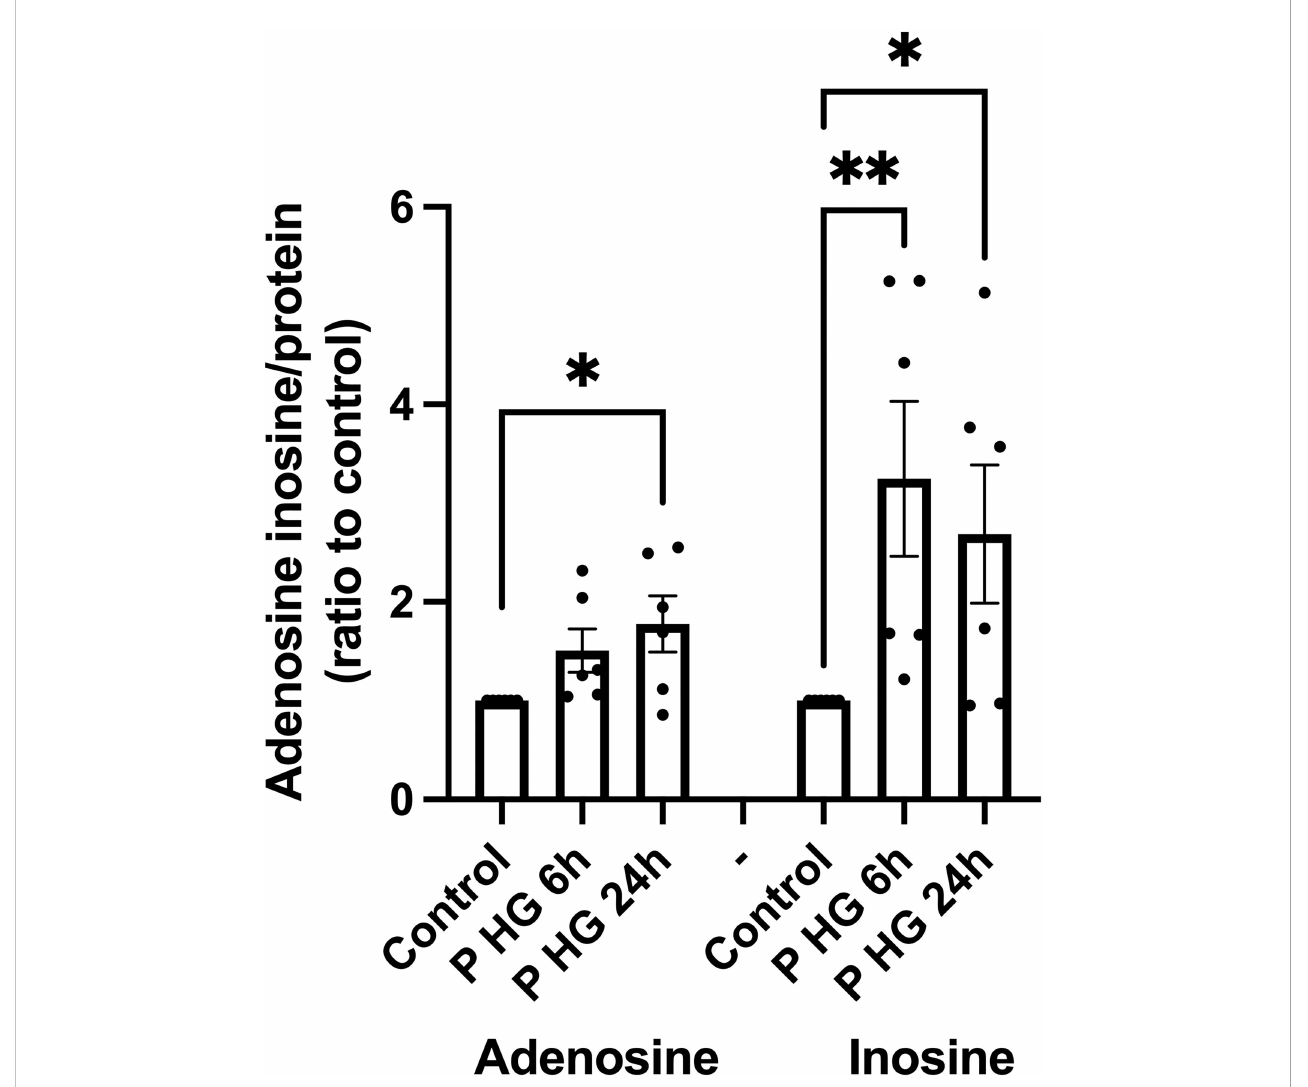
FIGURE 4 Palmitate + high glucose increases adenosine and inosine levels' (A) Intracellu lar adenosine and inosine were quanti fi ed in EndoC-betaH1 cells after incubation for 6 or 24h with palmitate (1.5 mM solubilized in 2% BSA) + high glucose (20 mM) (P HG). Adenosine was quanti fi ed using an adenosine ELISA and inosine was quanti fi ed using an Inosine fl uorometric assay kit. Results were normalized to protein contents of the